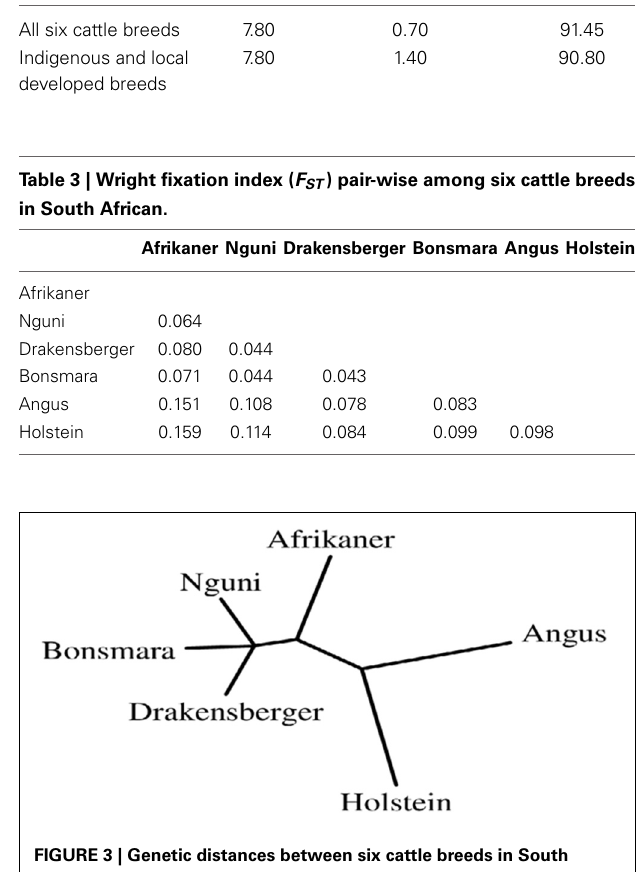
FIGURE 3 | Genetic distances between six cattle breeds in South Africa: Neighbor-joining relationship tree of tested cattle